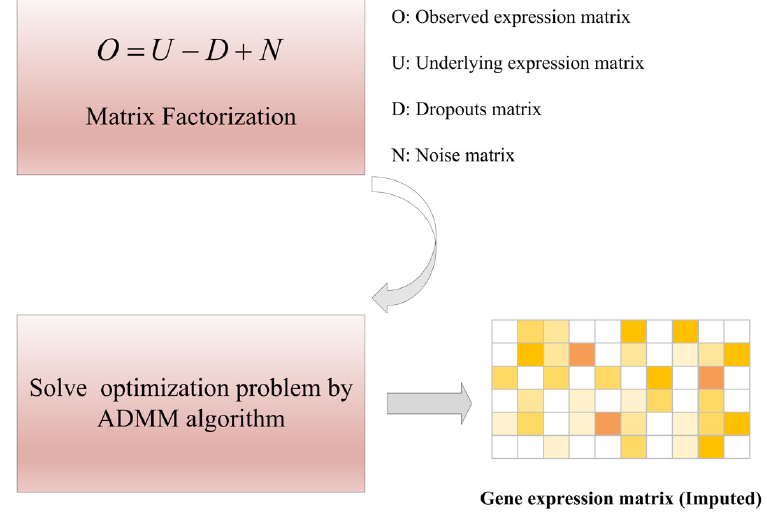
Figure 7. The framework of scRMD method [6].